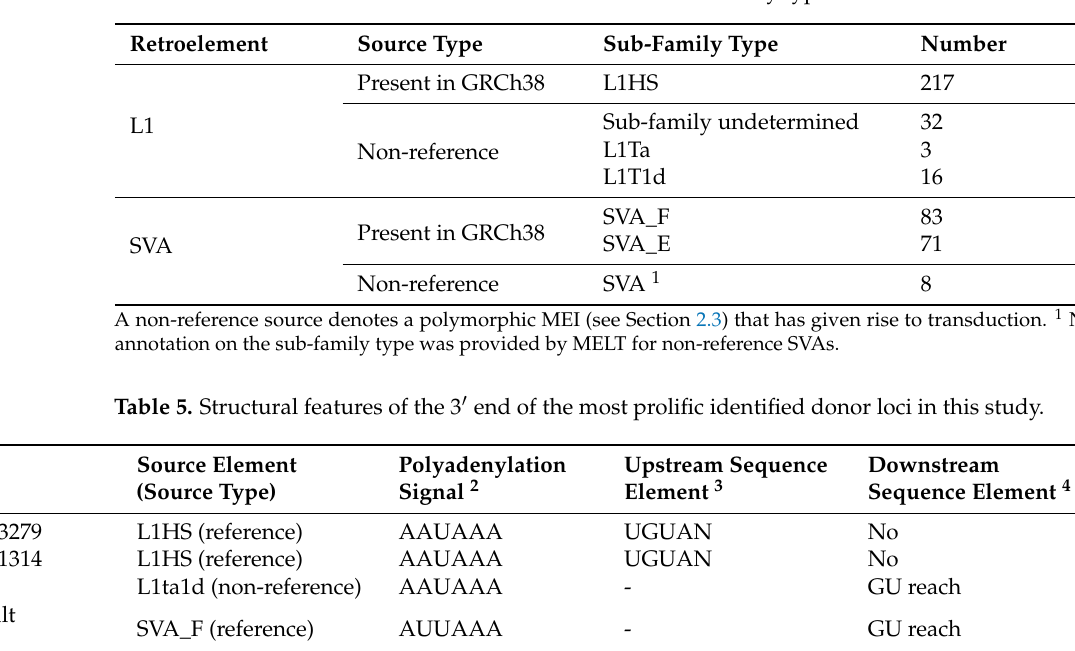
Table 4. Number of transduction sources based on their sub-family type.